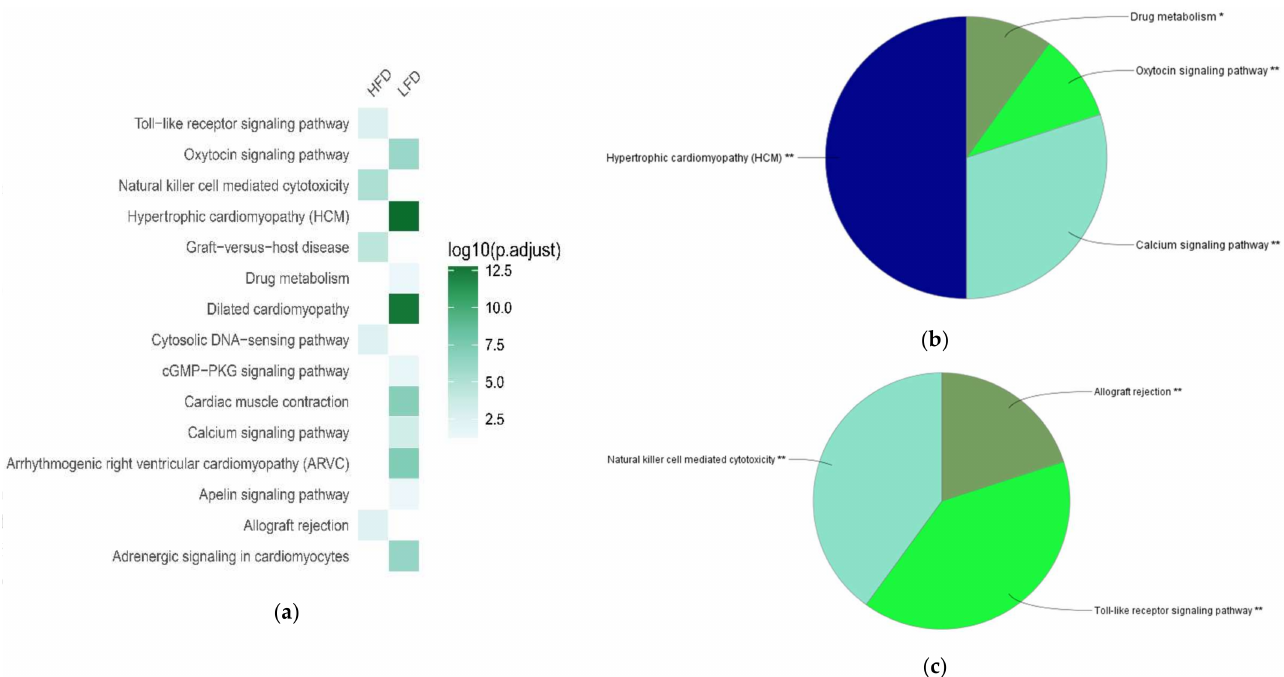
Figure 3. Comparing top Gene Ontology (GO) Kyoto Encyclopedia of Genes and Genomes (KEGG) terms associated with high-fat diet (HFD)-responsive genes in brown adipose tissue (BAT). Enrichment analysis was performed using differentially expressed genes in BAT between HFD and low-fat diet (LFD) groups. ( a ) Heat-map showing top GO KEGG annotation terms in BAT between HFD and LFD groups. ( b ) GO KEGG terms associated with downregulated genes in BAT of HFD-fed obese mice. ( c ) GO KEGG terms associated with upregulated genes in BAT of HFD-fed obese